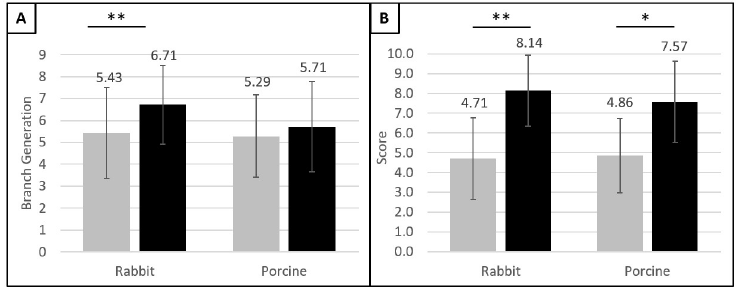
Fig 5. Trainees’ subjective ratings on pre- and post-injection images. (A) Smallest discernable pulmonary vessel branch generation; (B) Comfort level in performing a lobectomy with the images (Mean ± SD; � p < 0.05, �� p < 0.005). Legend—grey: before CF800 injection; black: after CF800 injection.